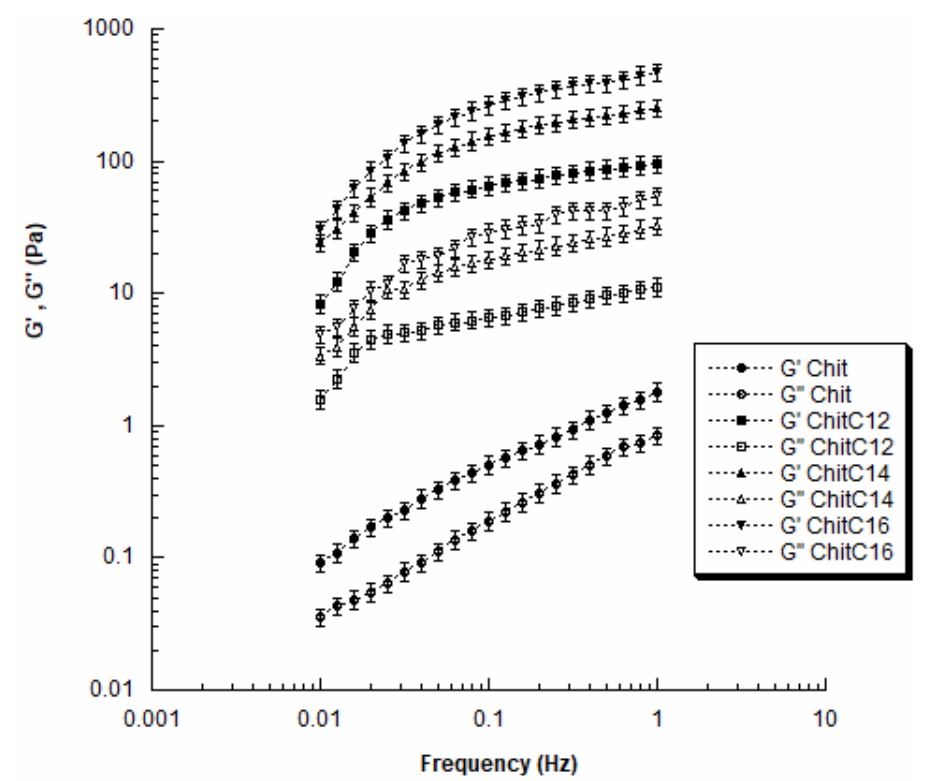
Figure 6. Dynamic mechanical analysis. Results from small amplitude oscillatory shear tests: storage modulus (G’) and loss modulus (G’’) as function of frequency for Chit, ChitC12, ChitC14, and ChitC16. Data are reported as mean value, and error bars represent the standard deviation. The results were analyzed using ANOVA followed by Bonferroni post hoc tests. The level of significance was set at p < 0.05.